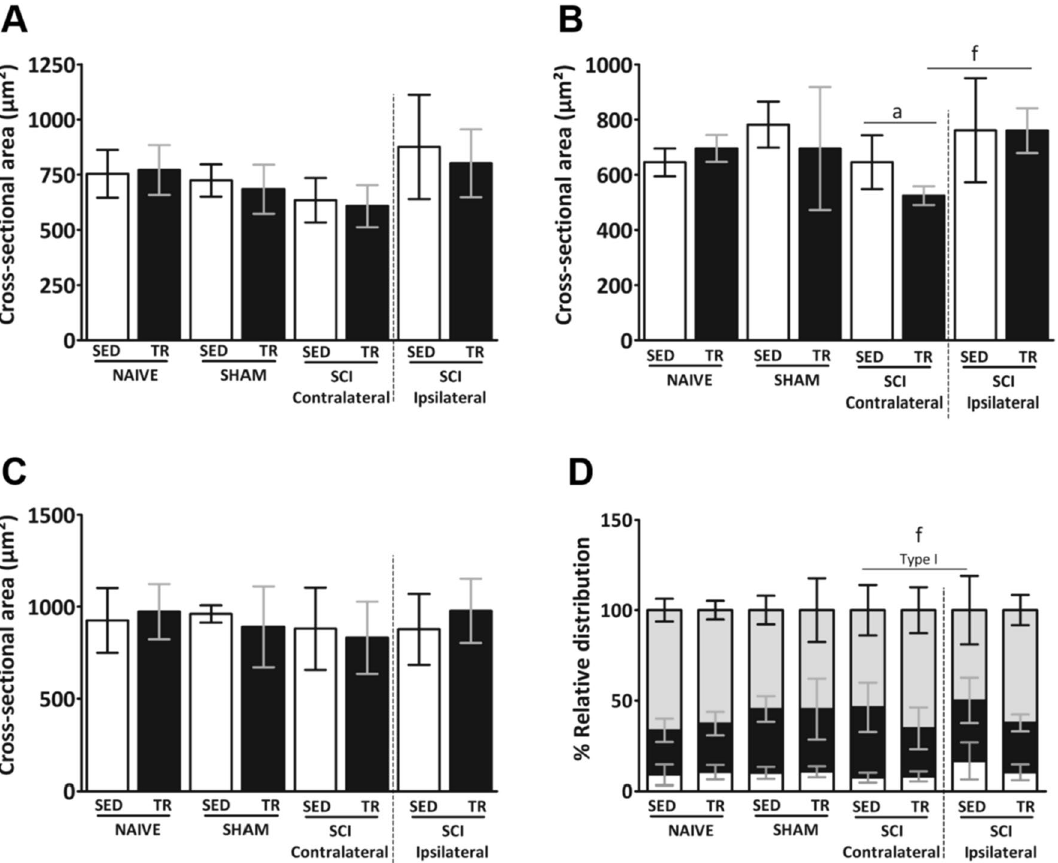
Figure 8. Analysis of fiber type composition in the respiratory muscle. ( A–C ) muscle fiber cross sectional area and ( D ) percentage of fiber type relative in diaphragmatic muscle. Data are presented as mean ± SD (n = 6). Significance: a p < 0.05 compared to TR group; f p <